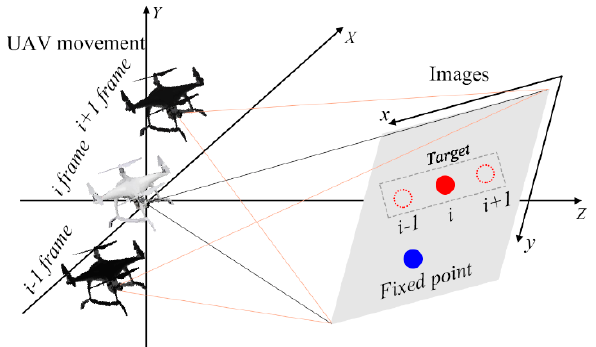
Figure 4. Schematic diagram of in-plane displacement drift compensation when the UAV is hovering.